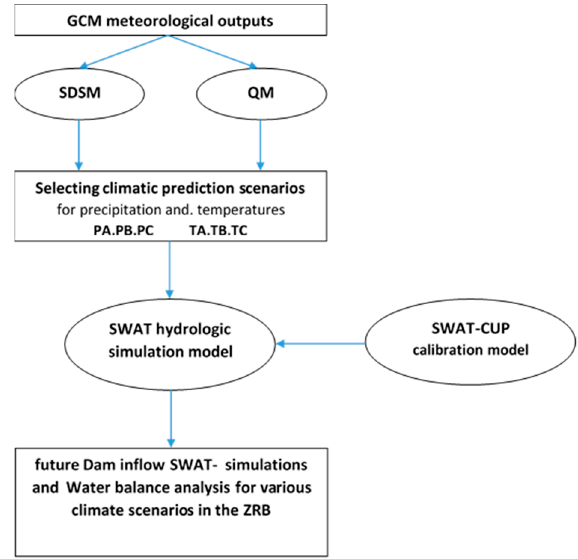
Figure 1. Flowchart of the Zarrine River Basin (ZRB)- water resources simulation study.